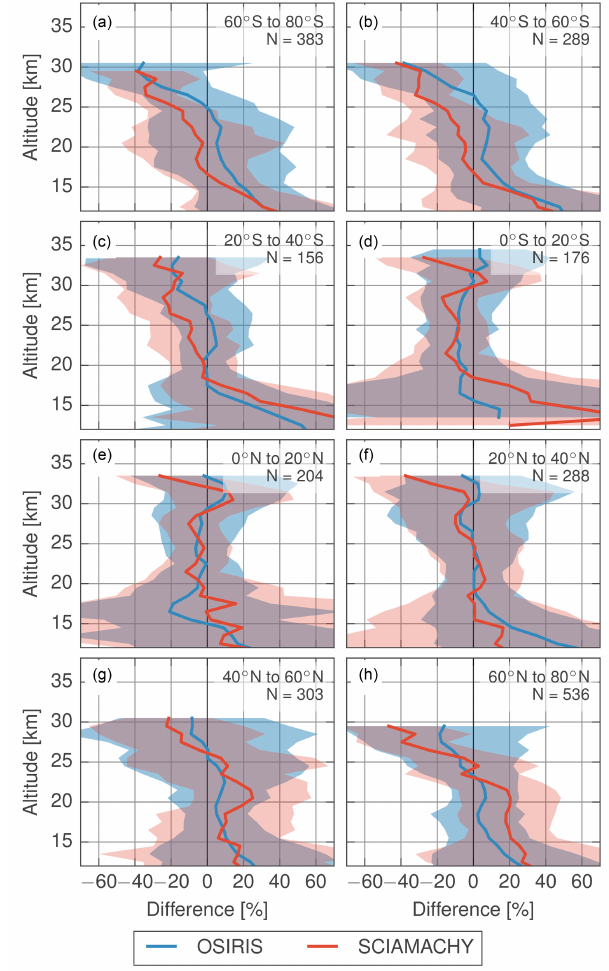
Figure 9. Coincident comparison with SAGE II when both OSIRIS and SCIAMACHY measurements have been processed with the USask